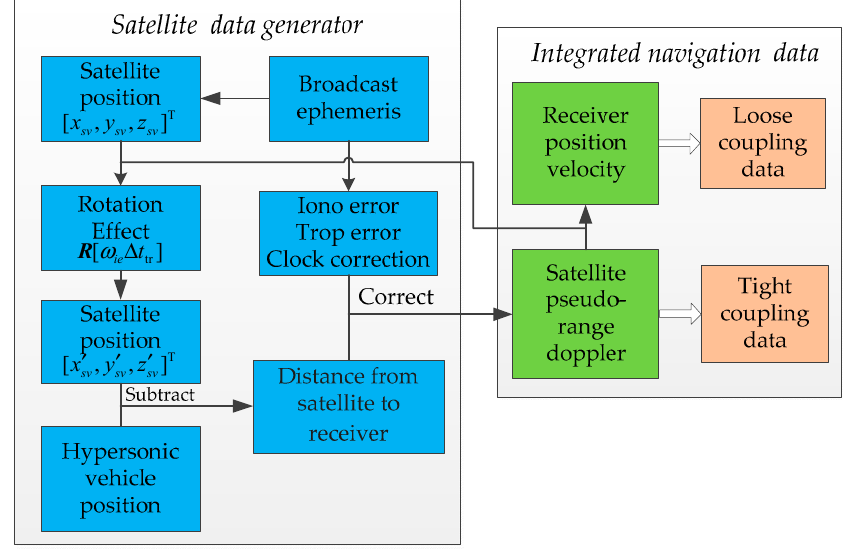
Figure 6. Satellite data simulation.